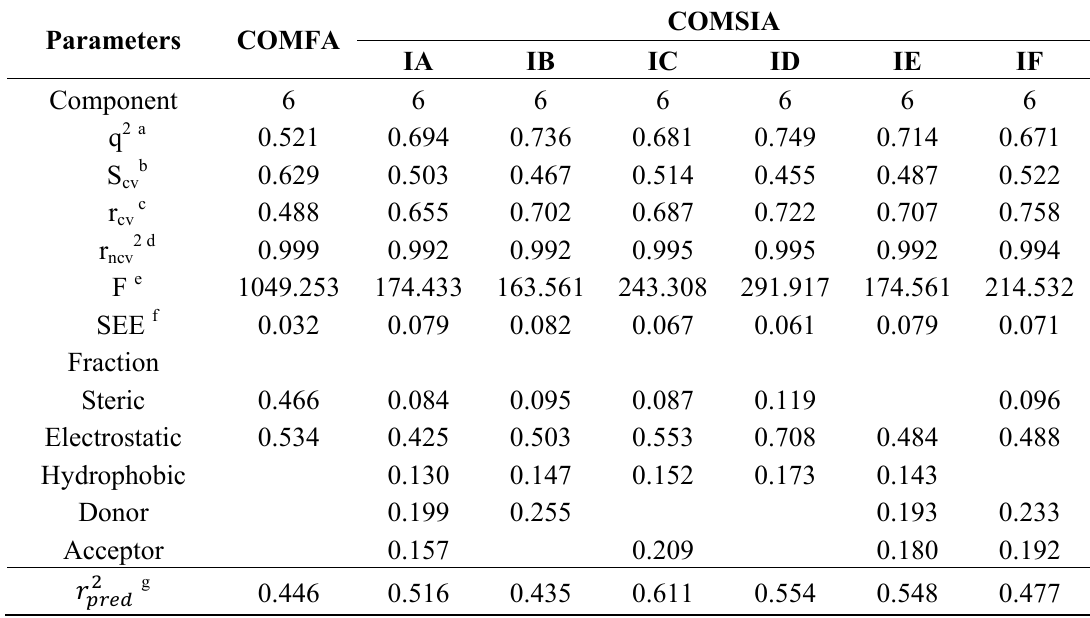
Table 3. Summary of statistical results for COMFA and COMSIA models.